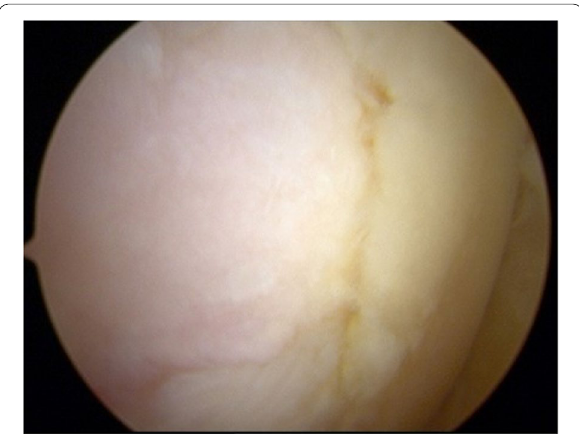
Fig. 9 Cartilage repair with Hyaluronic Acid Scaffold plus BMAC (Bone Marrow Aspirate Concentrate) and fibrin glue in the trochlea, medial femoral condyle and patella